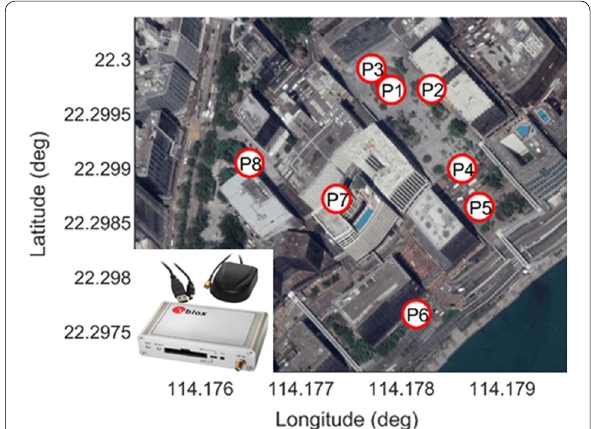
Fig. 7 Locations of static experiment in a Hong Kong urban canyon (from Google